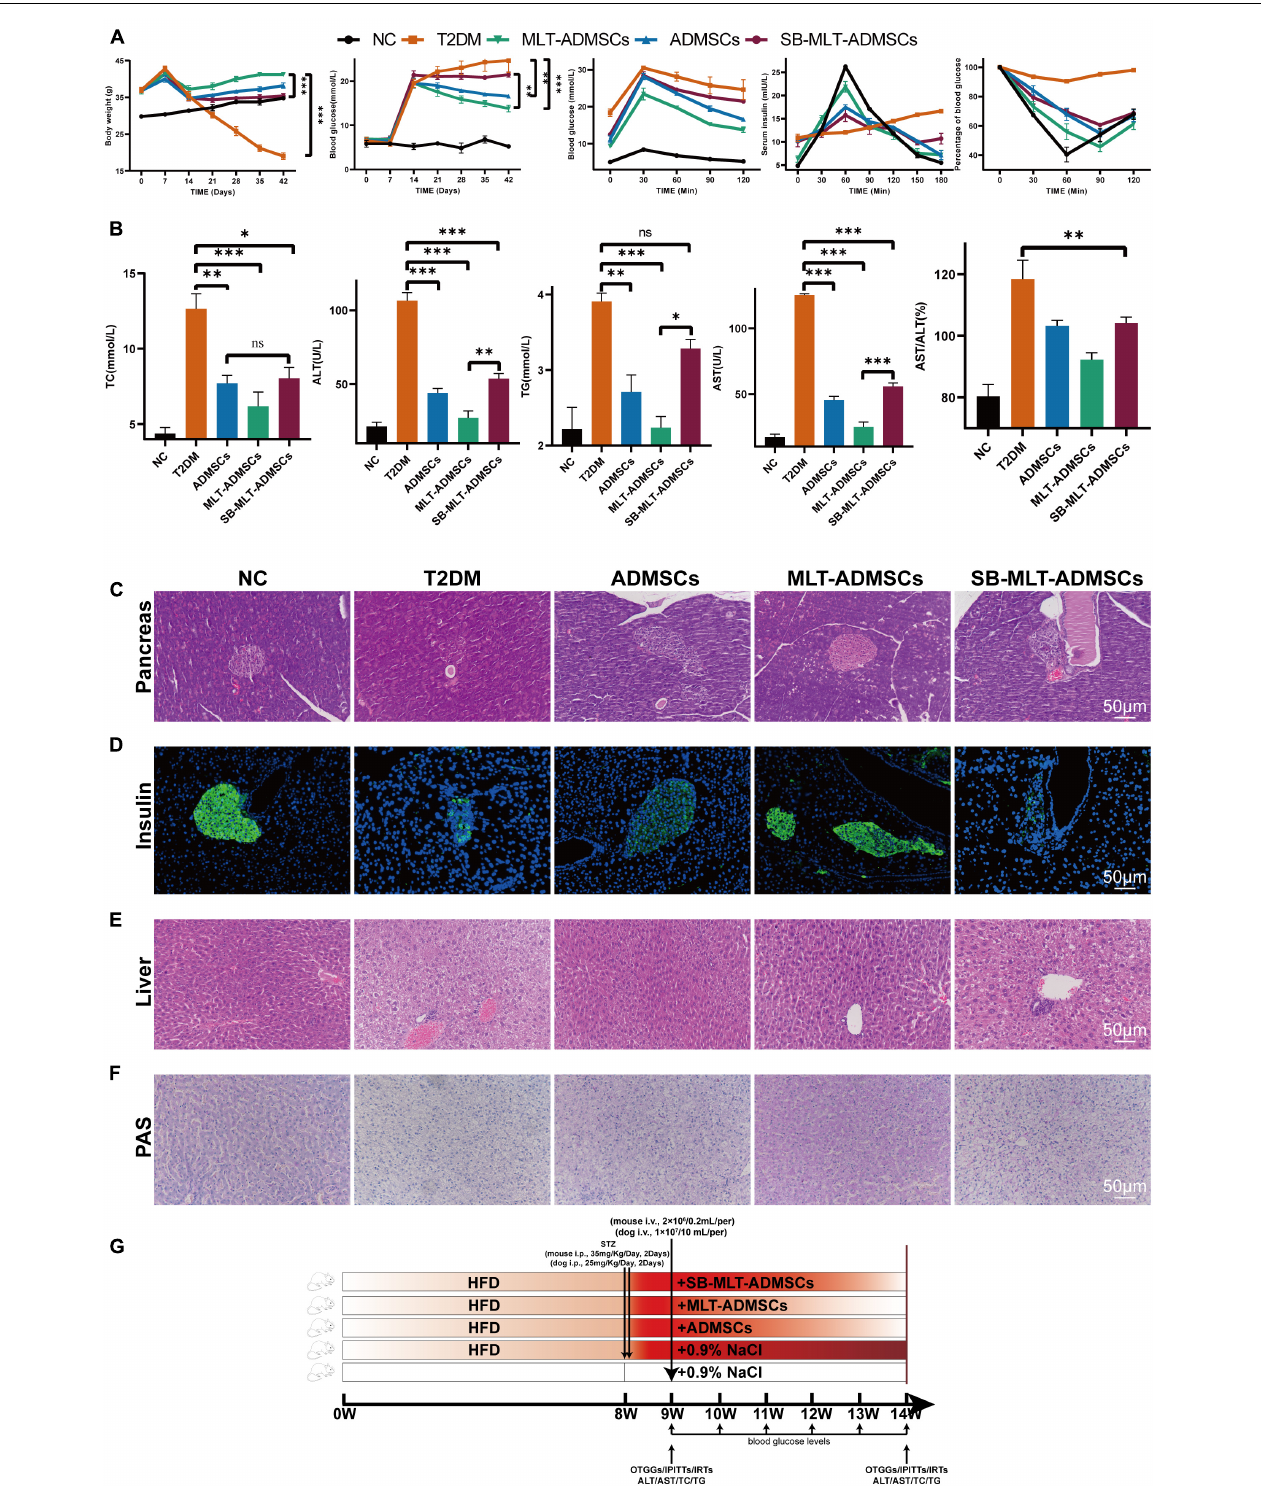
FIGURE 10 | Inhibition of the TGF- β pathway blocked the promotion of the efficacy of ADMSCs by MLT. (A) Levels of blood glucose metabolism and insulin resistance, including random blood glucose levels, OTGG, IRTs, and IPITT. (B) Liver function and glucose metabolism, including TC, TG, ALT, AST, and AST/ALT. (C) Pancreas H&E staining. (D) Pancreas immunofluorescence of insulin. (E) Liver H&E staining. (F) Liver PAS staining. (G) Experimental design. Values in this figure are the mean ± SE; n = 5 mice per group; ns > 0.05, ∗ p < 0.05, ∗∗ p < 0.01, ∗∗∗ p < 0.001 determined by a repeated-measures ANOVA.